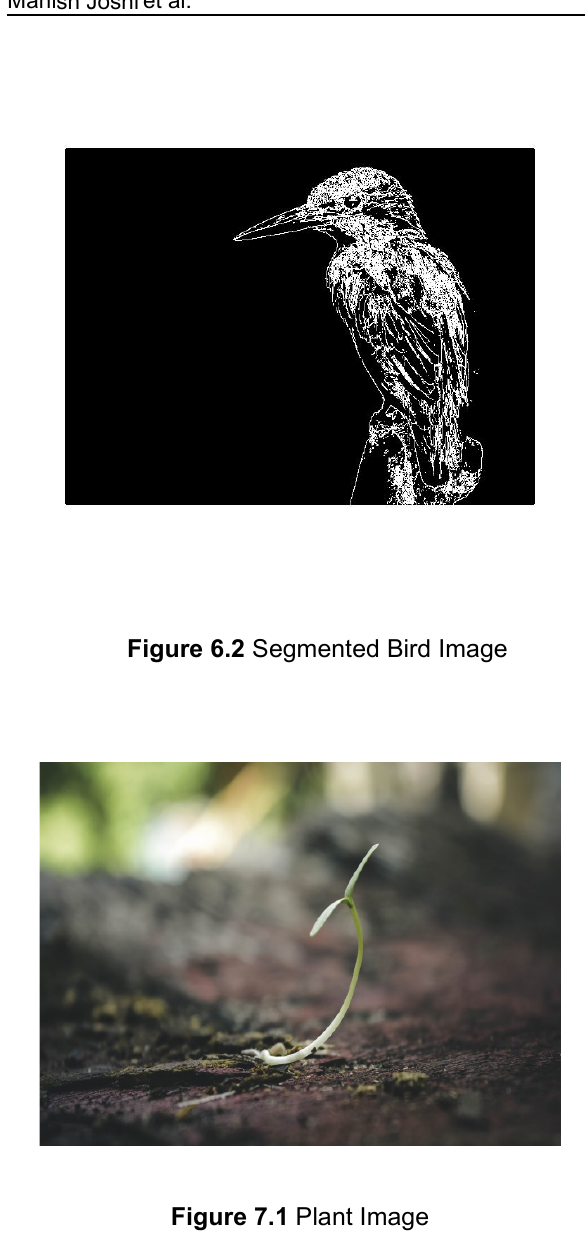
Figure 7.1 Plant Image